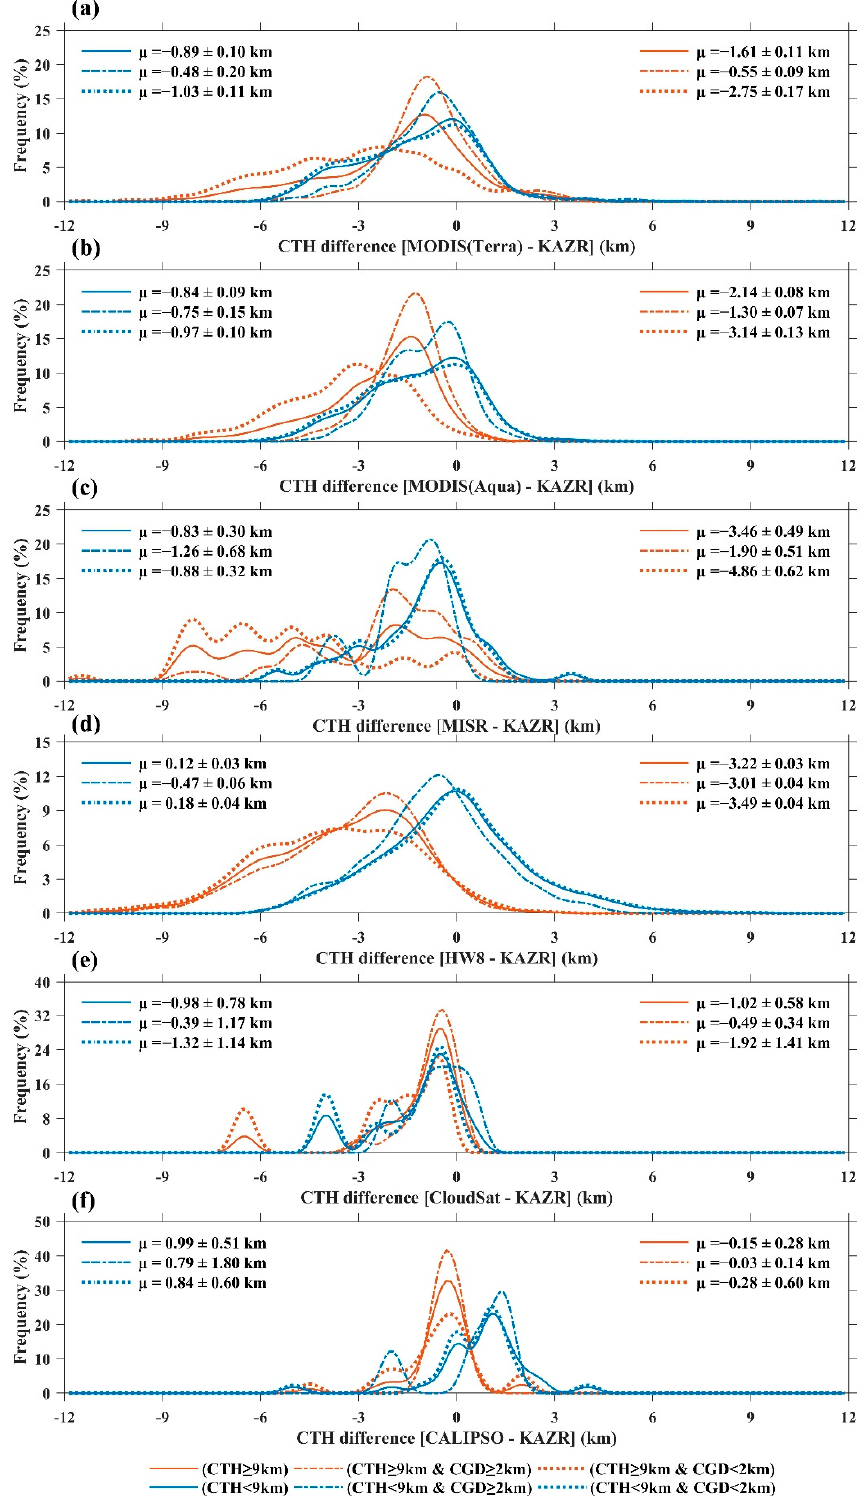
Figure 13. Frequency line graph of the difference between satellite and KAZR cloud-top heights for all cases under different conditions of cloud-top heights and cloud geometrical depth. μ represents the mean CTH difference at the 95% significance level. These subplots are for different satellite-KAZR pairs, ( a ) MODIS(Terra), ( b ) MODIS(Aqua), ( c ) MISR, ( d ) HW8, ( e ) CloudSat, and ( f ) CALIPSO.